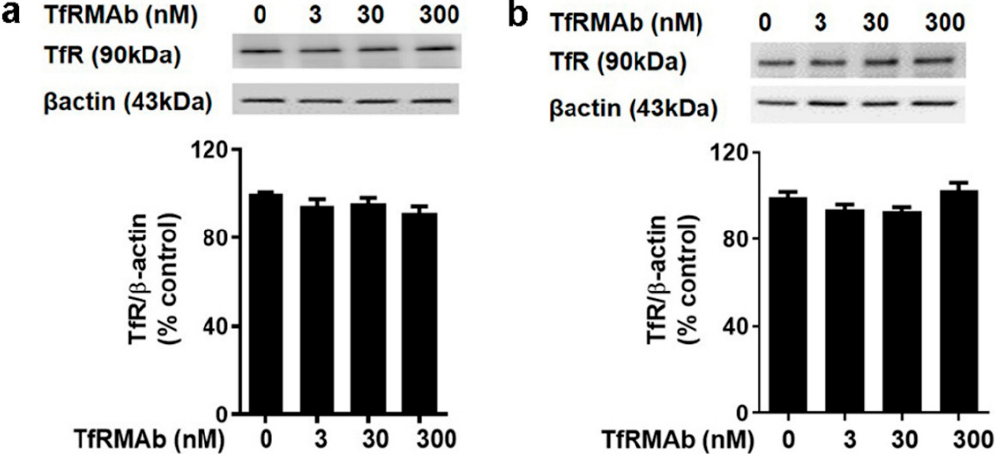
Figure 7. TfR protein levels in cultured mouse brain endothelial cells following acute and chronic treatment with the high-affinity bivalent TfRMAb. bEND.3 cells were treated with indicated doses of TfRMAb for 24 h ( a ) or 96 h ( b ). TfR levels were detected by western blotting using a non-competing antibody against the TfR. Data is shown as the mean ± SEM of n = 3 independent experiments done in duplicates.